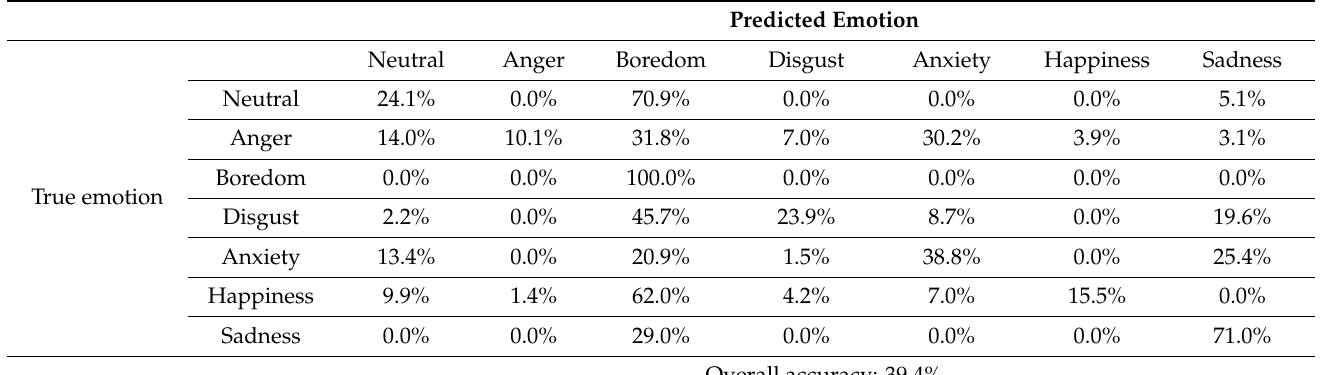
Table 12. Confusion matrix of the emotion classification results of the baseline CNN that was trained on the German EMO-DB mixed with the PSTATION noise.